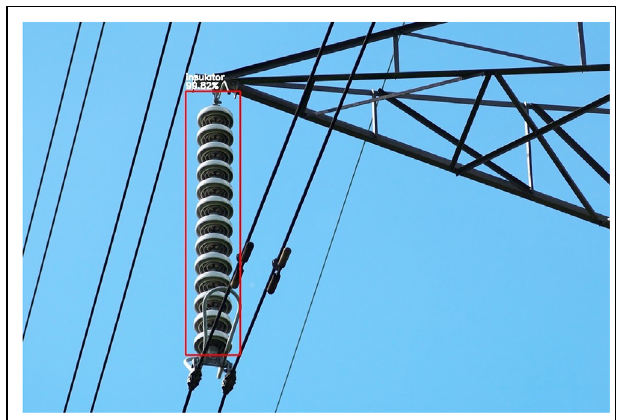
FIGURE 10 | Demonstration that our model has learned how to detect other categories of insulators.